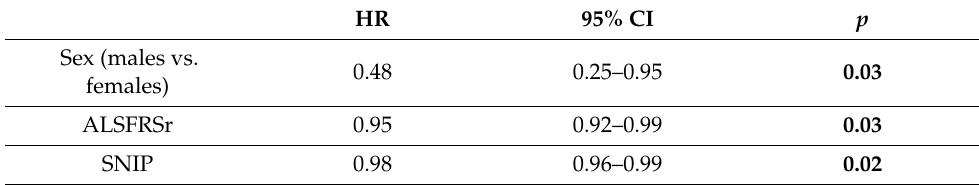
Table 3. Multivariate COX proportional hazard model of predictors of PEG placement. HR 95% CI p Sex (males vs. 0.48 0.25–0.95 0.03 females) ALSFRSr 0.95 0.92–0.99 0.03 SNIP 0.98 0.96–0.99